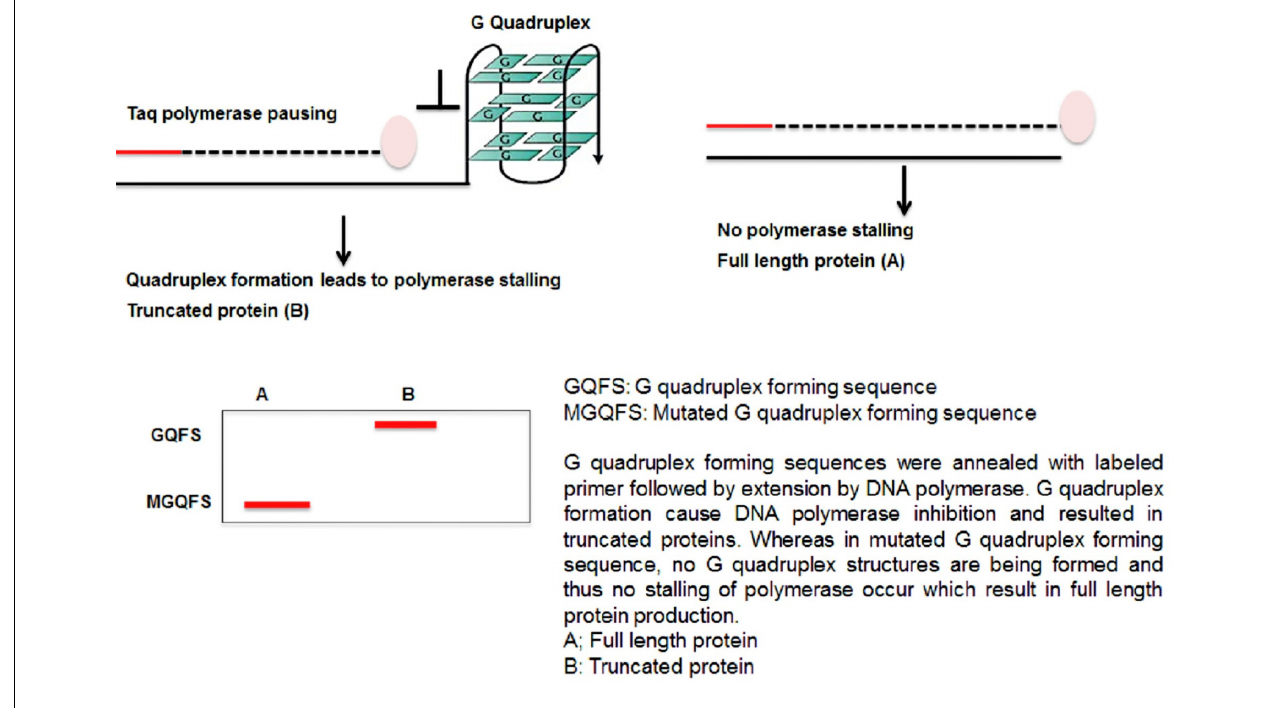
FIGURE 2 | Genome wide occurance of G quadrplex forming sequences in different part of the gene (Garg et al., 2016).